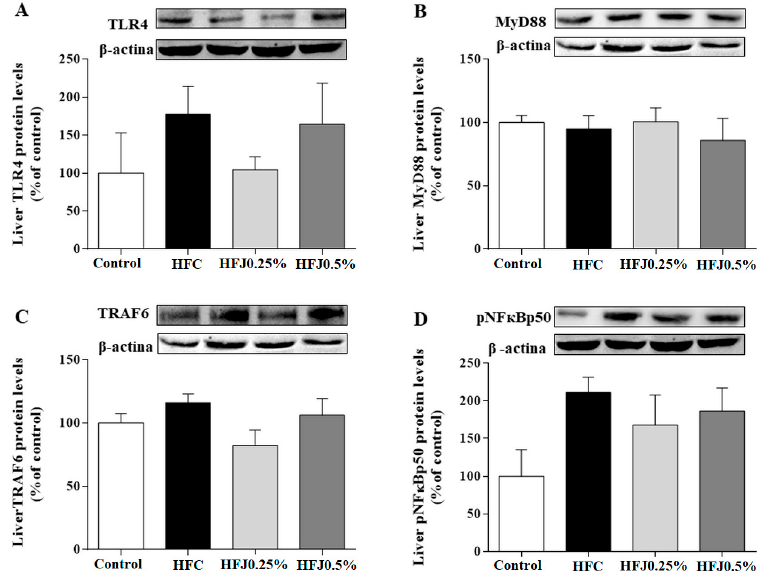
Figure 5. Protein expression of the NF κ B pathway in liver: ( A ) TLR4; ( B ) MYD88; ( C ) TRAF6; and ( D )